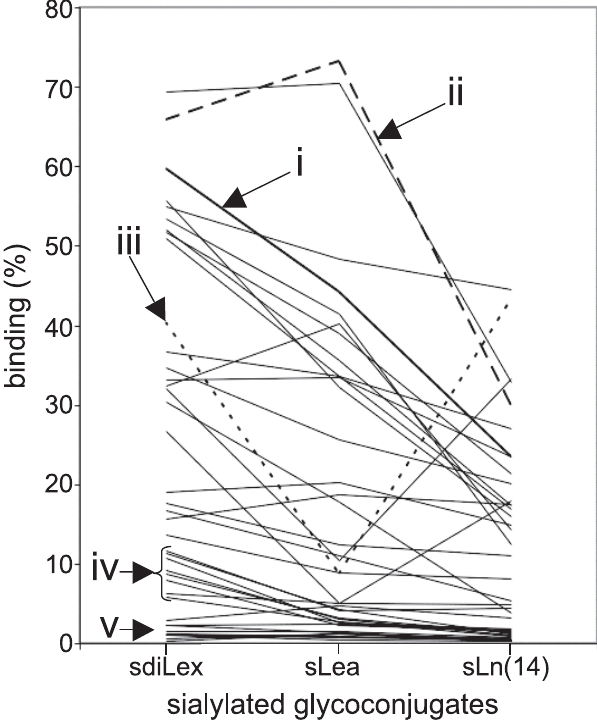
Figure 5. Different Sialyl-Dependent Binding Modes of H. pylori Identified by Use of sdiLex, sLea, and sLn Conjugates A total of 39 Swedish clinical isolates were investigated for detailed sialyl- dependent binding properties. Representatives of the different binding modes for 125 I-labeled sialylated glycans are illustrated in the diagram: (i) (in thick line) binds efficiently to all three sialylated glycans with preferential binding to sdiLex; (ii) binds to all three sialylated glycans, with better binding to sLea ( ‘‘ K -shaped ’’ hatched line); (iii) binds preferentially to sdiLex and sLn(14) ( ‘‘ V-shaped ’’ dotted line); (iv) binds preferentially to sdiLex but exhibits only modest binding for sLea and sLn(14) sialyl conjugates; and (v) binds modestly for all sialyl conjugates ( , 5% bound conjugate). The y axis gives the percentage of